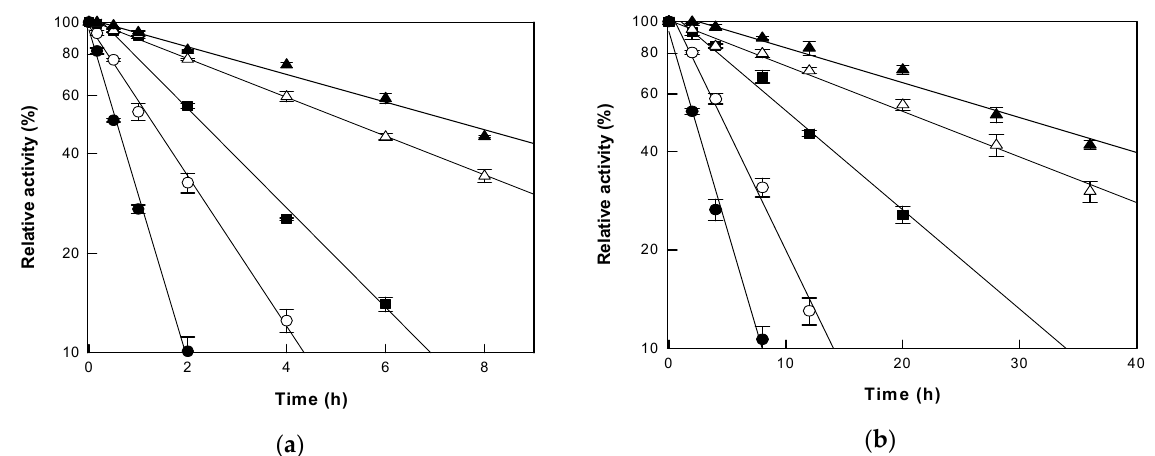
Figure 4. Thermal inactivation of cytolase PCL5 under ( a ) atmospheric pressure and ( b ) high hydrostatic pressure. The enzyme was incubated at 45 (closed triangle), 50 (open triangle), 55 (closed square), 60 (open circle), and 65 °C (closed circle). Data represent the means of three experiments ± standard deviation.